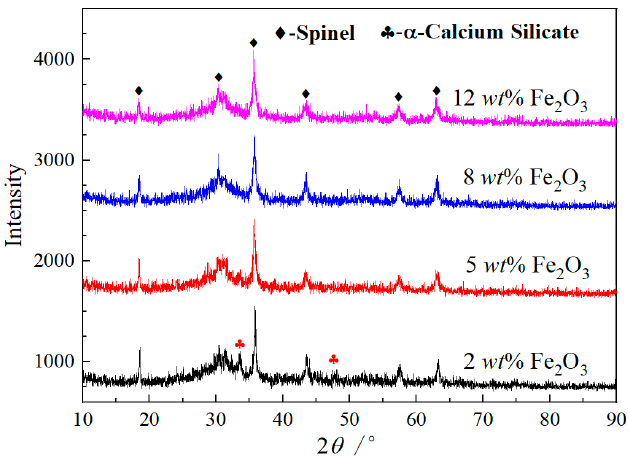
Figure 3. XRD patterns of steel slag samples.